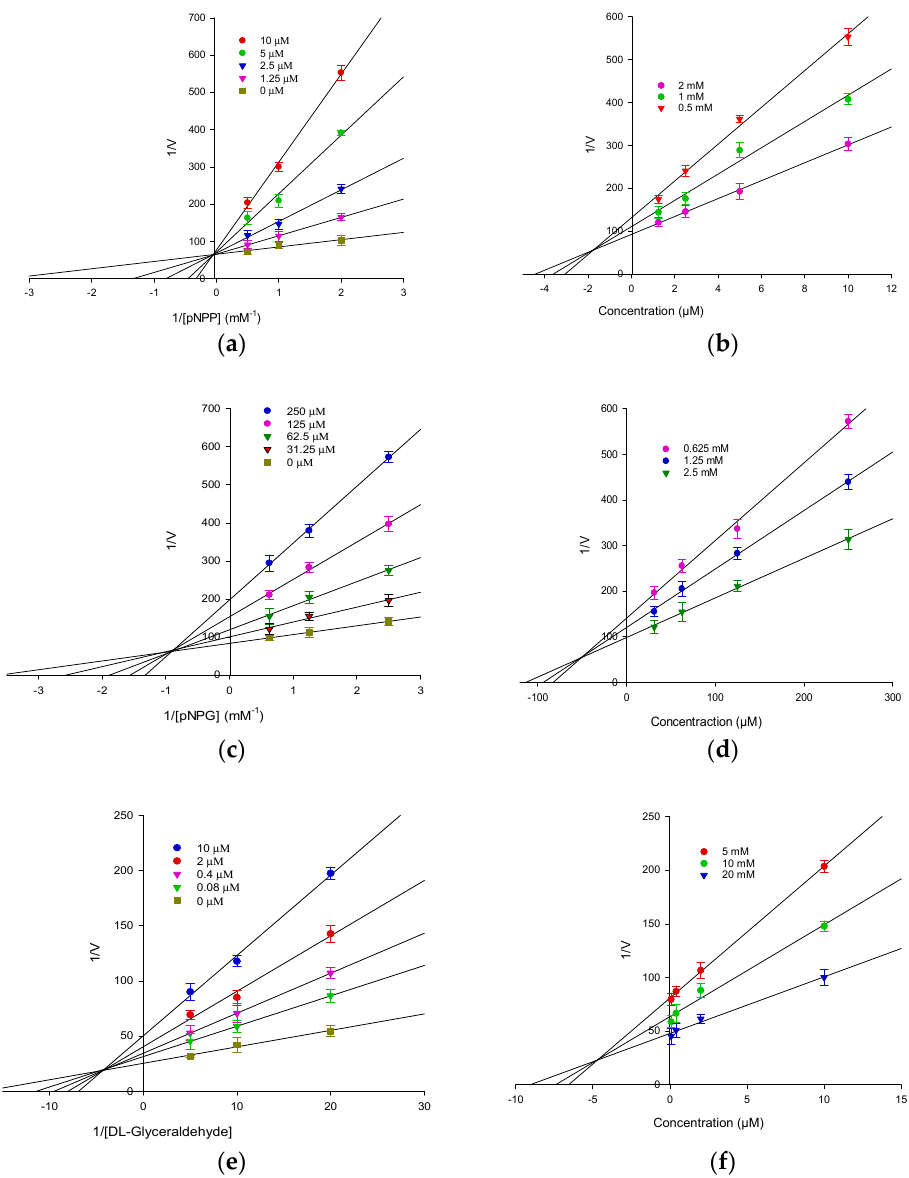
Figure 1. Lineweaver-Burk and Dixon plots for protein tyrosine phosphatase 1B (PTP1B), α -glucosidase and human recombinant aldose reductase (HRAR) inhibition by 6-FU. ( a ) Lineweaver-Burk plot for PTP1B inhibition by 6-FU was analyzed in the presence of different concentrations of sample as follows: 0 μ M ( ■ ), 1.25 μ M ( ▼ ), 2.5 μ M ( ▼ ), 5 μ M ( ● ), and 10 μ M ( ● ). ( b ) Dixon plots of PTP1B inhibition by 6-FU: 2 mM ( • ), 1.0 mM ( • ), and 0.5 mM ( (cid:72) ) for pNPP. ( c )